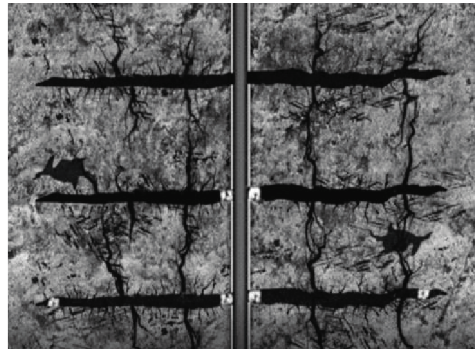
Figure 2: Fractures and wormholes in vertical wells generated by acid